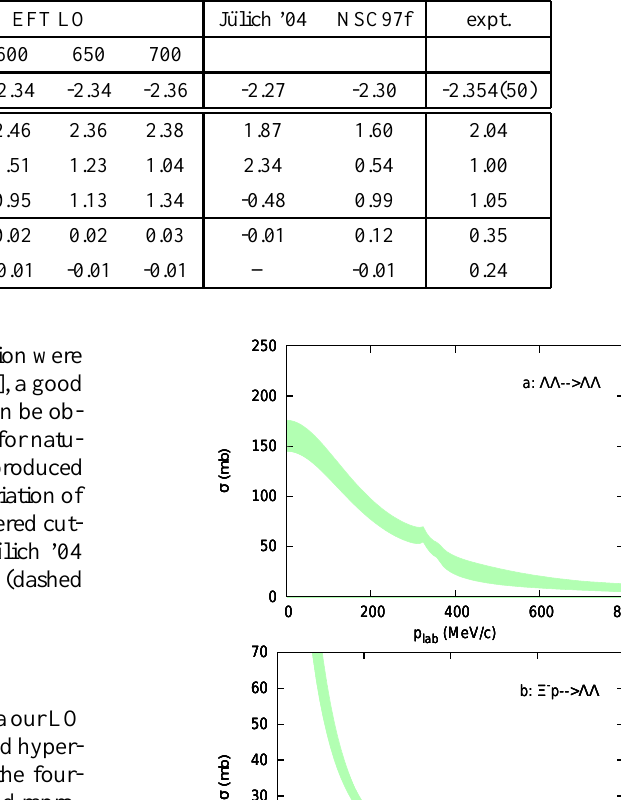
H binding energy and Λ separation energies for 4 Table 2. 3 Λ